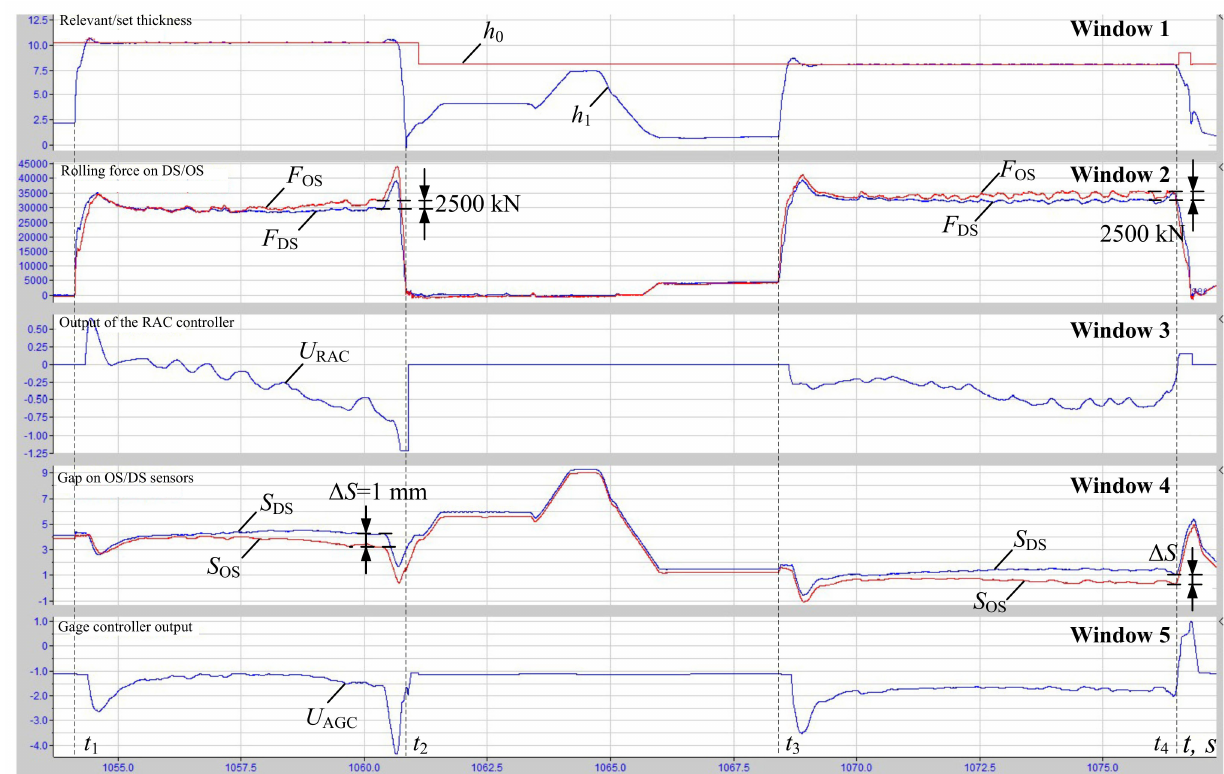
Figure 13. The oscillograph records similar to Figure 6 at the implementation of the developed method and introduction of the PD RAC